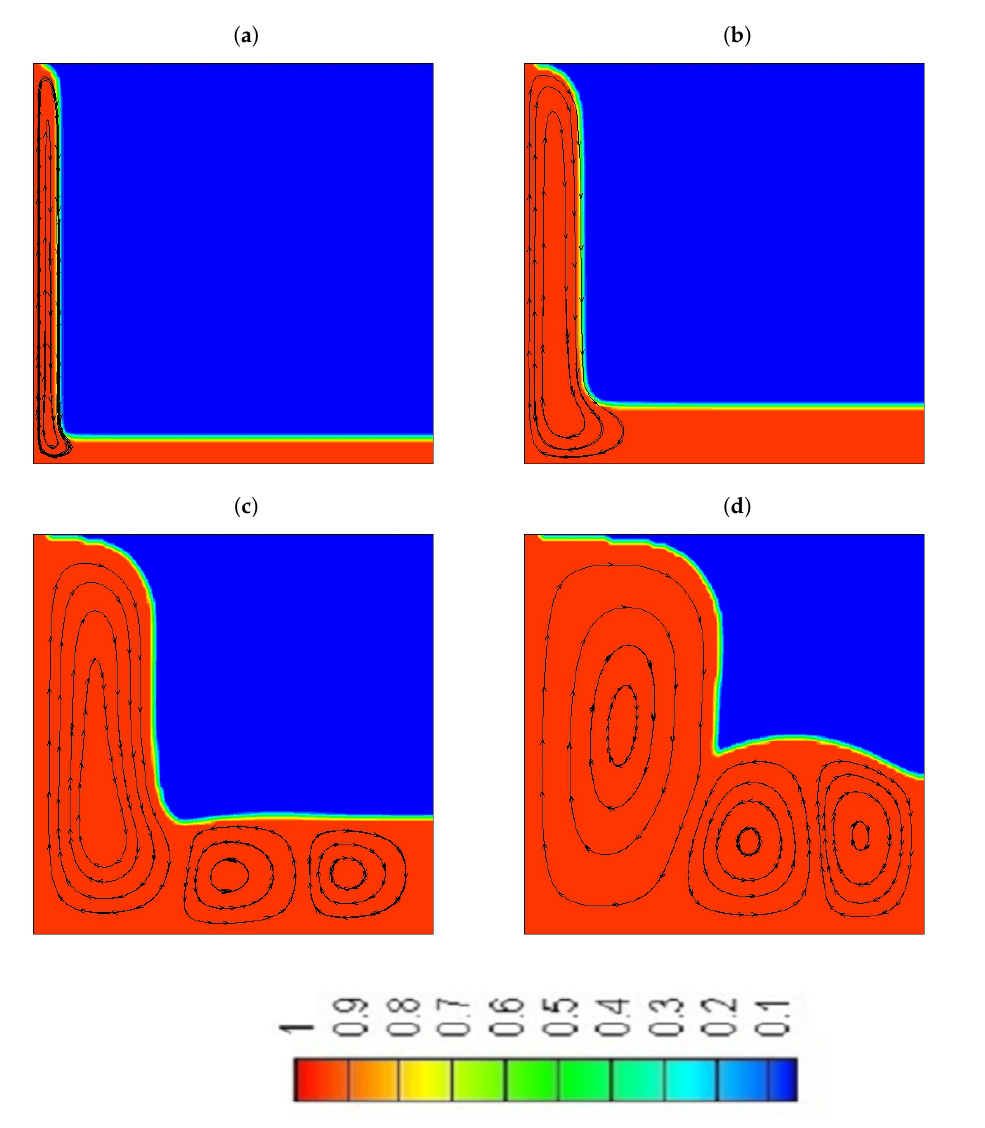
Figure 2. The evolution of solid-liquid interface profiles for the case of pure water φ w = 0 . ( a ) t = 1